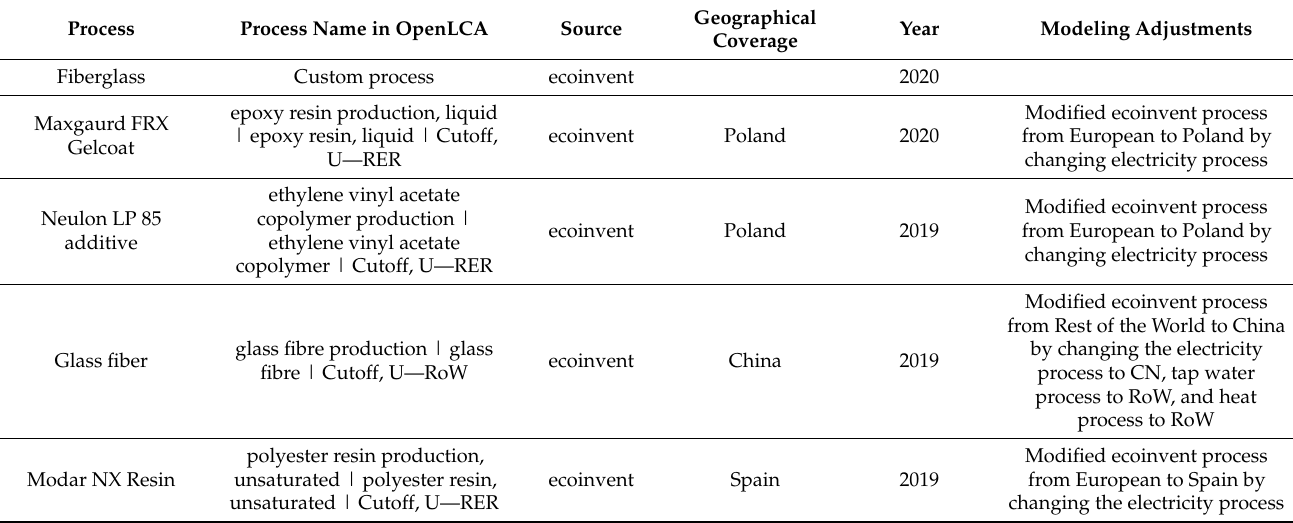
Table A2. Detailed modeling information for the fiberglass